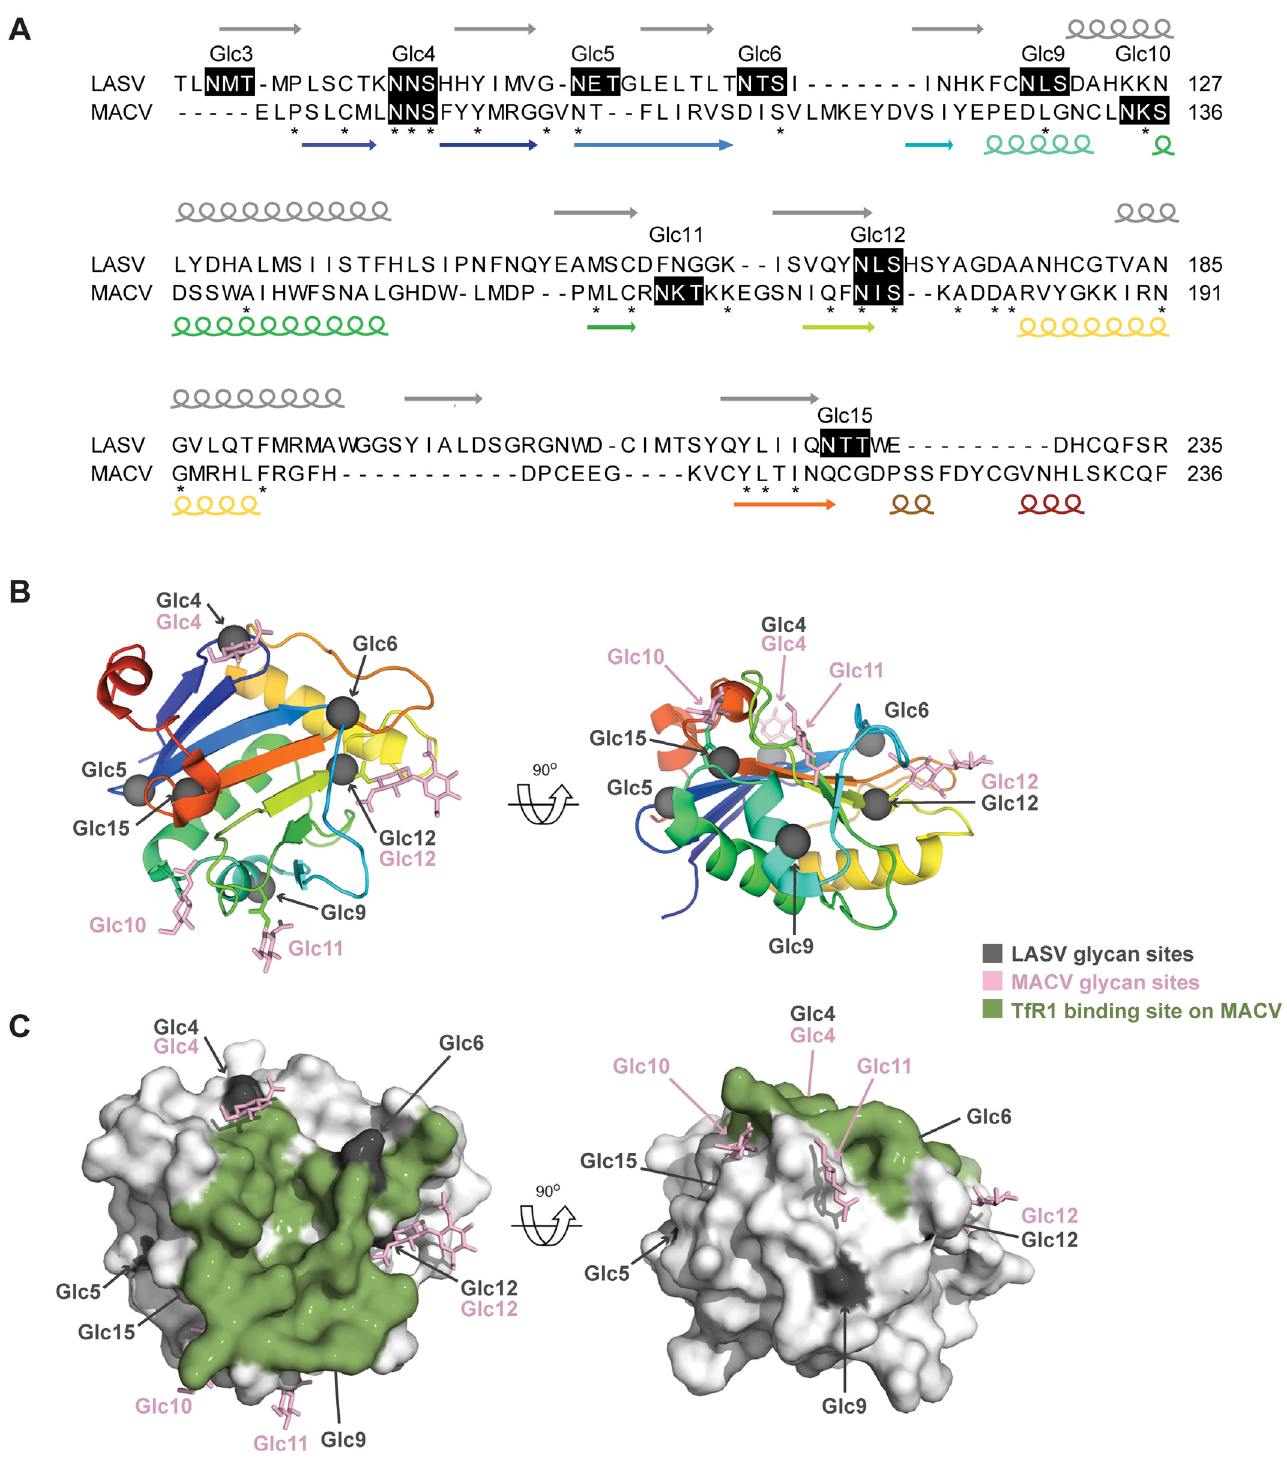
Fig 6. Mapping LASV GP-1 N-linked glycan sequons onto the structure of MACV GP-1. (A) The predicted secondary structure composition of LASV GP- 1 (above the sequence) was compared to the secondary structure observed in the crystal structure of MACV GP-1 (below the sequence, [48]). Arrows represent beta-sheets and spirals represent helices, the rainbow code corresponds to panel B. Stars indicate identical residues. The number and position of predicted N-linked glycans are indicated above black shaded sequons. The alignment and annotations were extracted from the arenavirus GP-1 sequences alignment presented in S1 Fig. (B) Cartoon diagram of MACV GP-1 colored as a rainbow ramped from blue (N-terminus) to red (C-terminus). Sites of